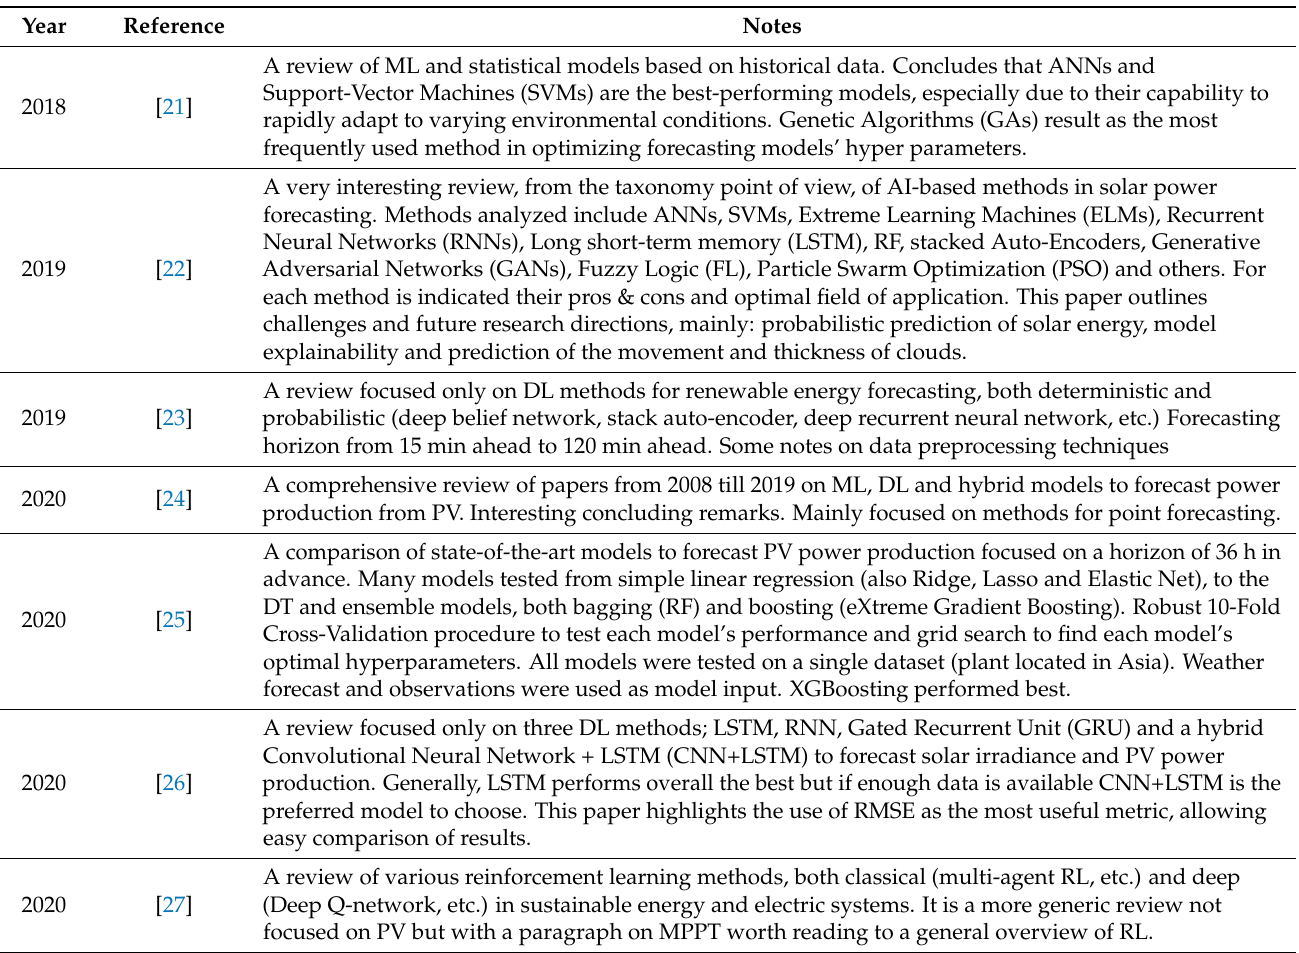
Table 1. Review papers in forecasting power PV production. Publication year considered: